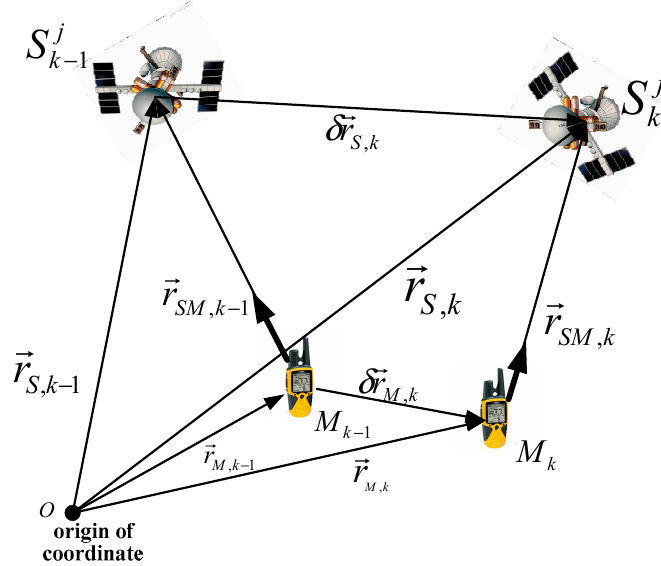
j S and S j k 1 − and k − 1 k   → → r r S , k − 1 and r S , k are position of satellite numbered j at and kS r , are position of satellite numbered j 1, − kS → r S , k is the satellite flight distance from epoch k − 1 to k , M k − 1 m and M k n are → → r M , k − 1 and r M , k are position of GPS receiver at epoch k − 1 and k , → → r SM , k − 1 and r SM , k are the distances